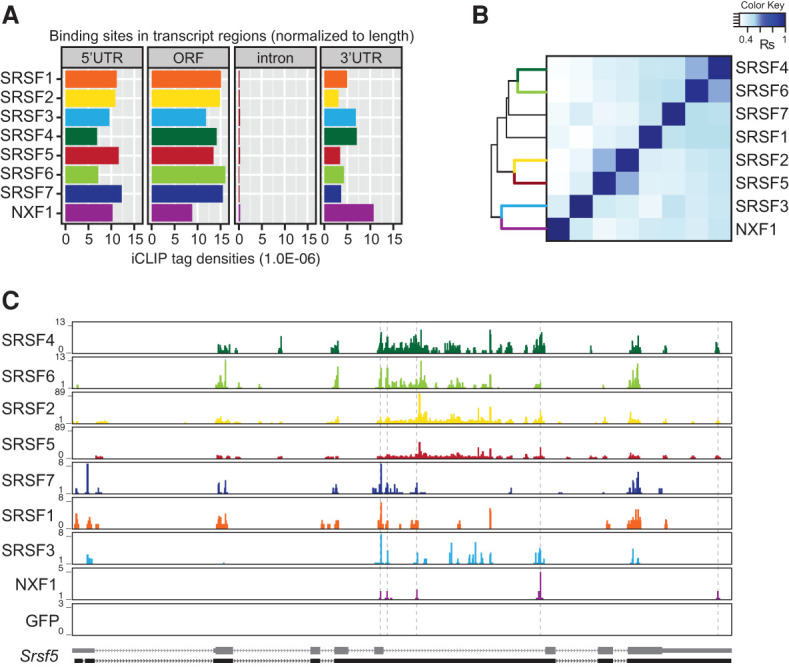
SR proteins and NXF1 cobind within exons. (A) Number of significant cross-link events of SR proteins and NXF1 (FDR < 0.05) in different transcript regions normalized to feature length. (B) Hierarchical clustering using distance correlation and Spearman rank correlation of exon cobinding between SR proteins and NXF1 using normalized FDR iCLIP tag counts. (C) Browser shots showing binding profiles for GFP-tagged SRSF1–7, NXF1, and GFP-NLS on the Srsf5 gene. SR proteins of the same group share similar binding patterns. Srsf5 was not detected as export target of any SR protein.